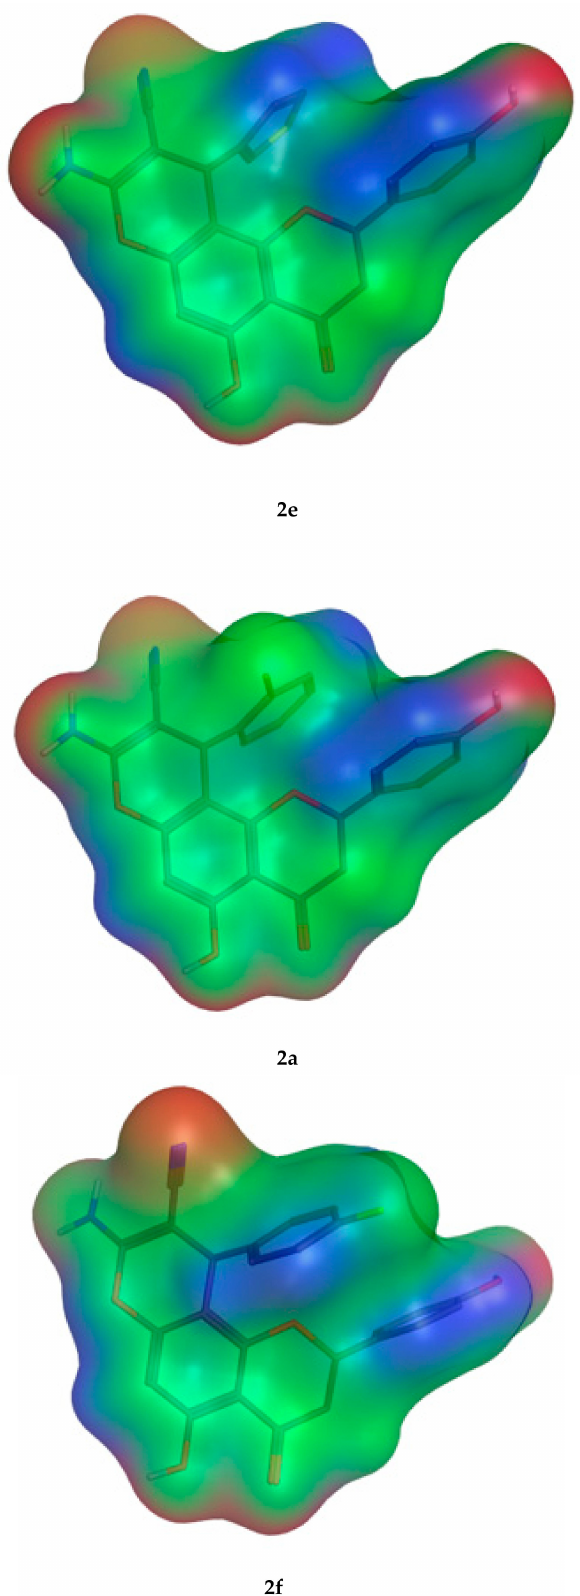
Figure 12. The 2D molecular surface di ff erences for the three representative compounds ( 2e , 2a , 2f ). The green color indicates the hydrophobic regions, and the red and blue denote the hydrophilic polar